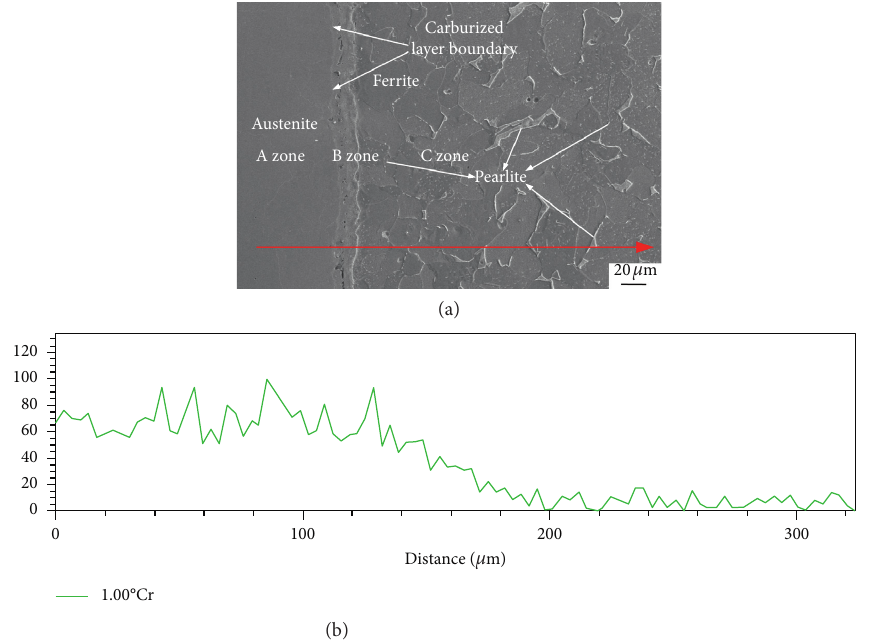
Figure 14: The SEM morphology of bonding layer at 60% reduction rate. (a) 200x. (b) Line scan.